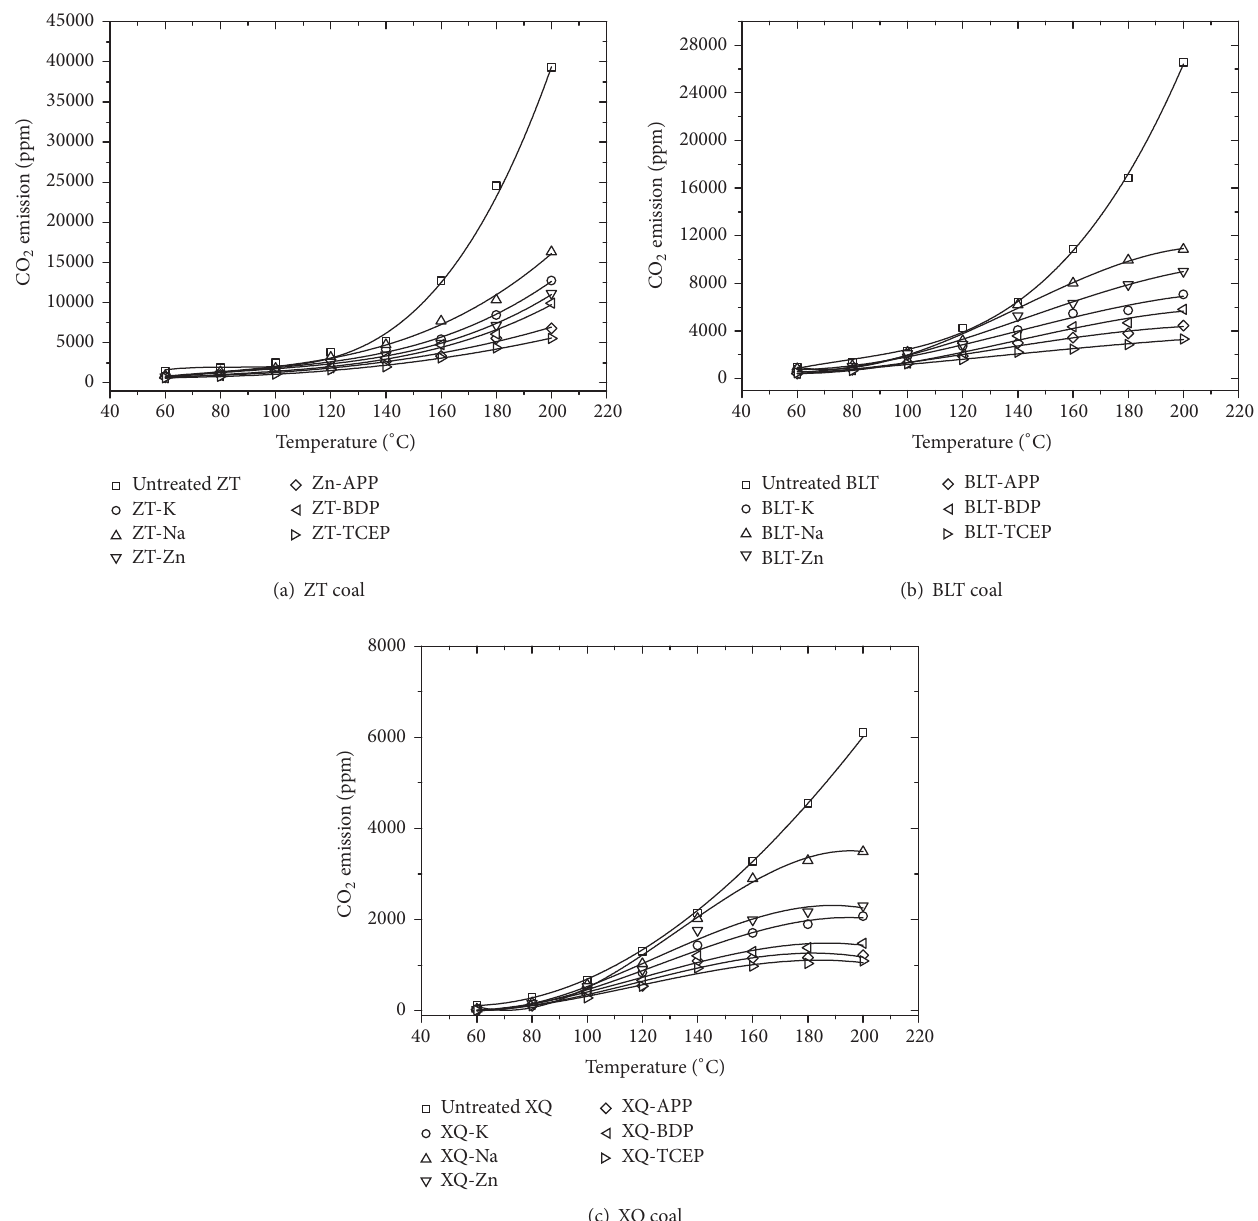
Figure 6: The CO 2 emission of coal samples before and after